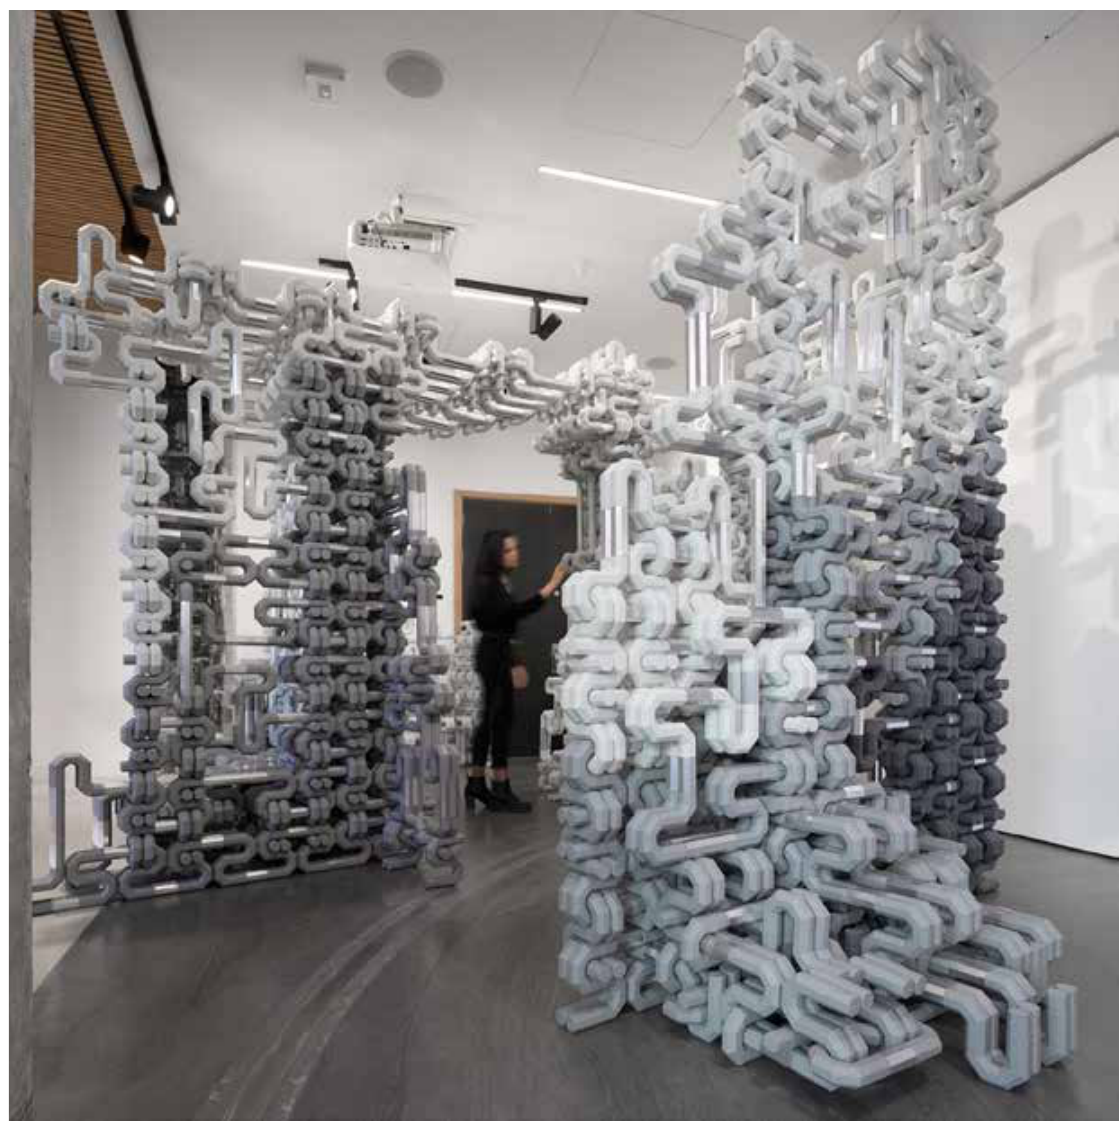
Figure 5—8 (page 84—87): SnP (2018). Recycled Nylon. Design: Daniel Widrig, Guan Lee, Igor Pantic. Team